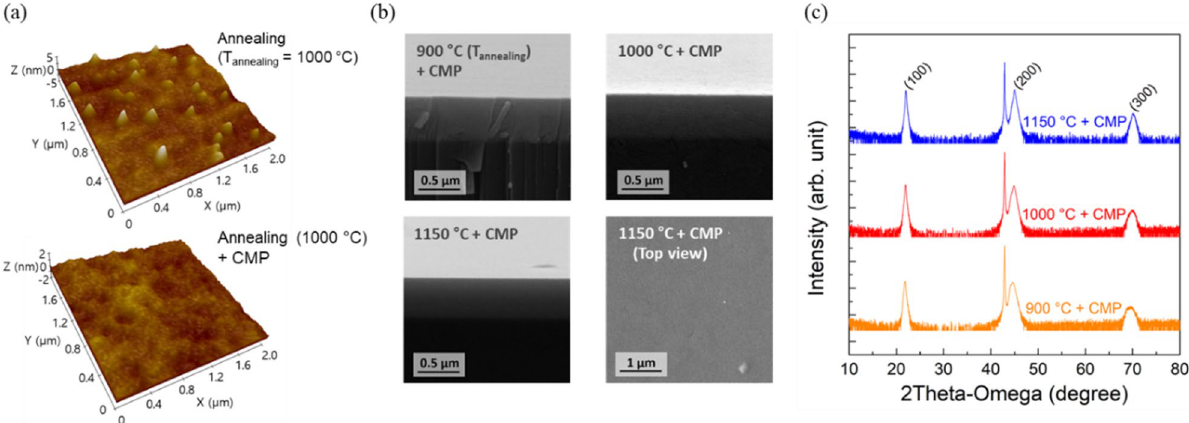
Figure 4. ( a ) Three-dimensional atomic force microscopy (AFM) images of BTO films annealed at 1000 °C before and after CMP. Z-axis scale of the film before CMP is larger than that of the film after CMP because of surface textures. ( b ) Cross-sectional scanning electron microscopy (SEM) images of BTO films annealed at 900, 1000, and 1150 °C after CMP, and the top view of the SEM image of the BTO film annealed at 1150 °C after CMP. ( c ) XRD patterns of BTO films annealed at 900, 1000, and 1150 °C after CMP.